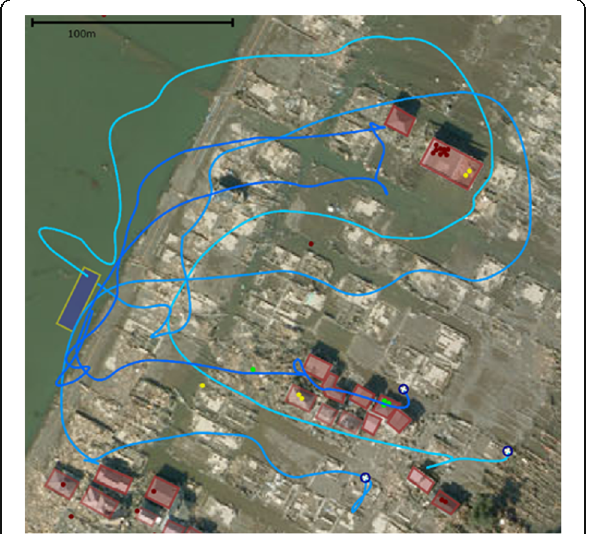
Fig. 3 Standard method showing the paths of three UAVs launched from the blue rectangle on the center left. Red, yellow, and green dots are survivors in different states of discovery. In this scenario, UAVS moved in a search pattern across the area starting in the northwest and ending in the southeast. Photograph by Geospatial Information Authority (GSI) of Japan (Geospatial Information Authority of Japan